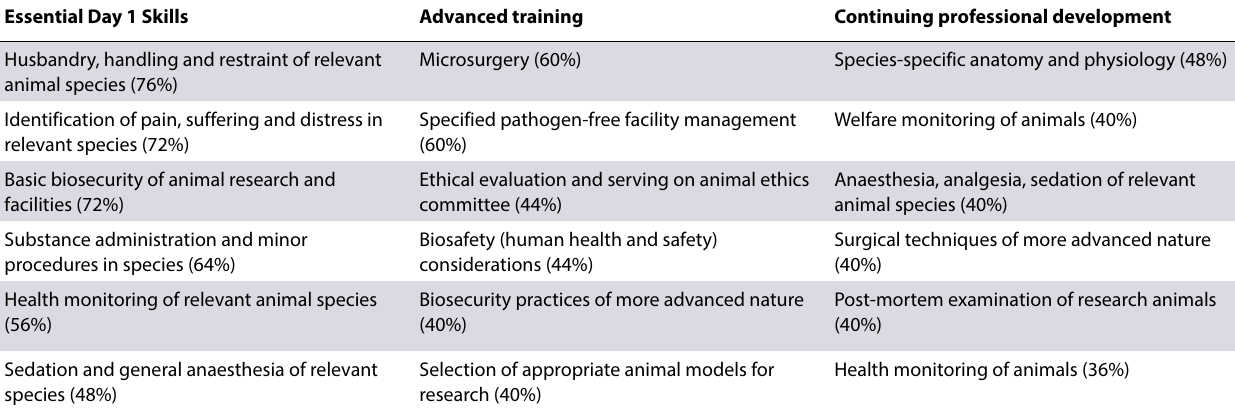
either essential Day 1 Skills, advanced training, or CPD